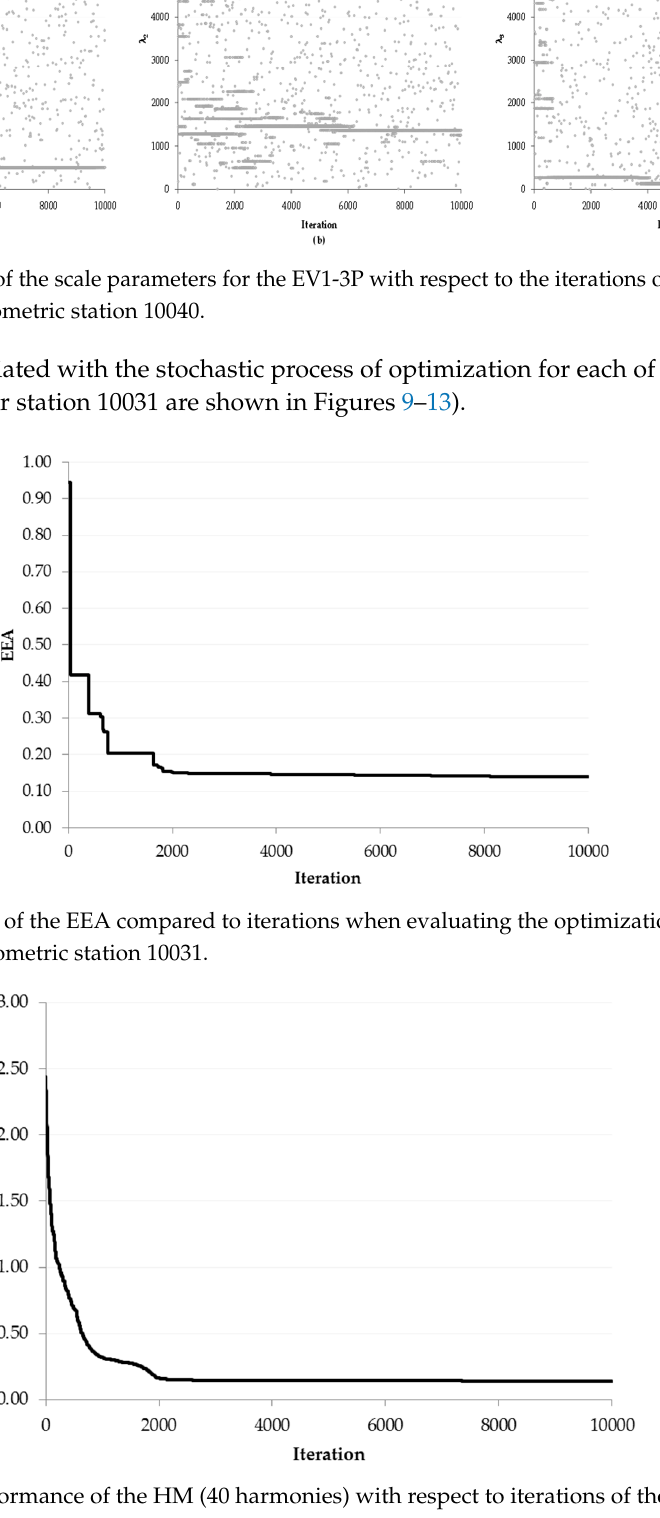
Figure 11. Behavior of the probability parameter for the EV1-3P with respect to the iterations of ( a ) P 1 ; ( b ) P 2 ; and ( c ) P 3 for hydrometric station 10031.